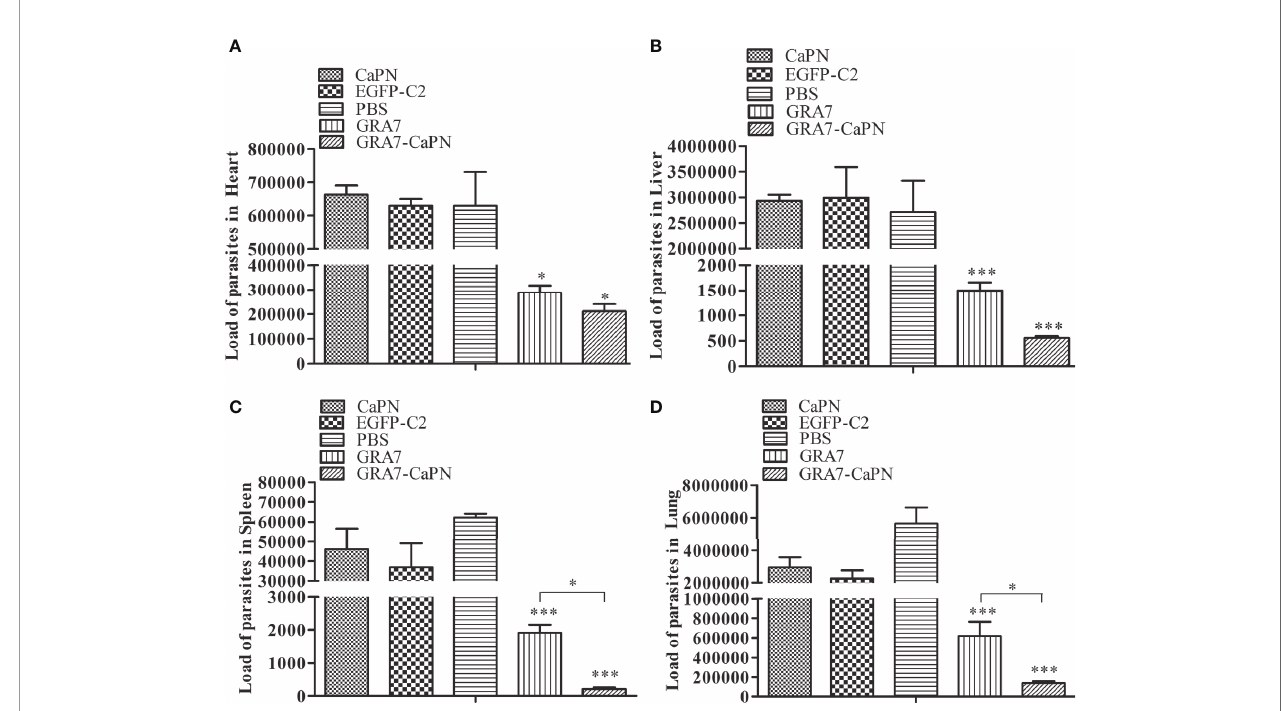
FIGURE 7 | Parasite burden in heart, liver, spleen, and lung tissues in the vaccine and control groups. (A) Parasite burden in the heart. (B) Parasite burden in the liver. (C) Parasite burden in the spleen. (D) Parasite burden in the lung. The data are shown as means ± SD for three experiments. * P < 0.05, *** P <